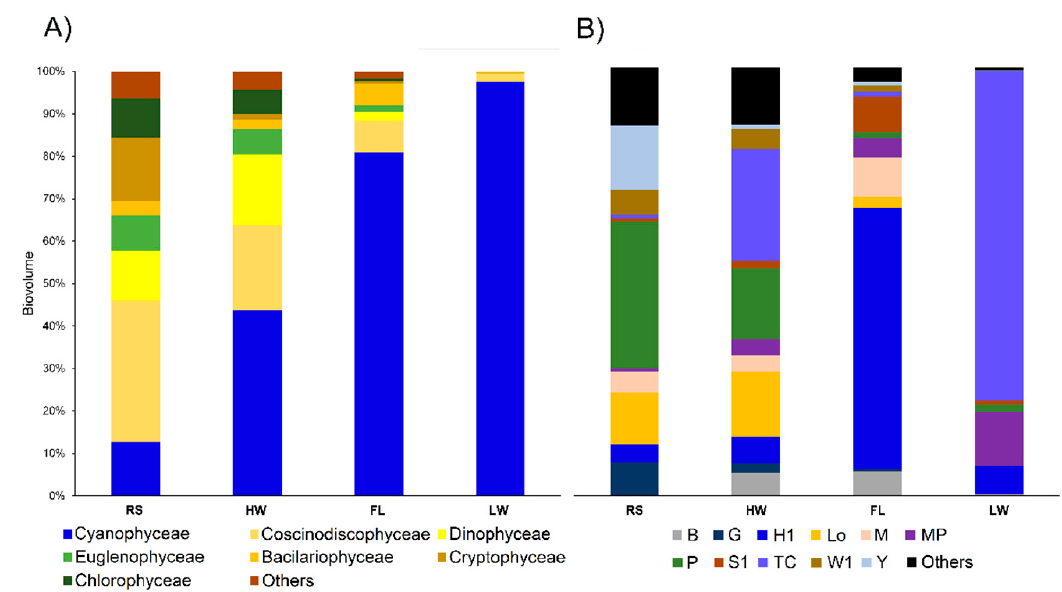
Figure 2. Relative phytoplankton class biomass ( A ) and functional groups biomass ( B ). Rising period (RS), high-water period (HW), flushing period (FL), low-water period (LW), B–G–H1–Lo–M–MP–P–S1–Tc–W1–Y are functional groups that had at least 5% of total biovolume in at least one hydrological period. Others are the sum of functional groups that did not respect the 5% threshold.